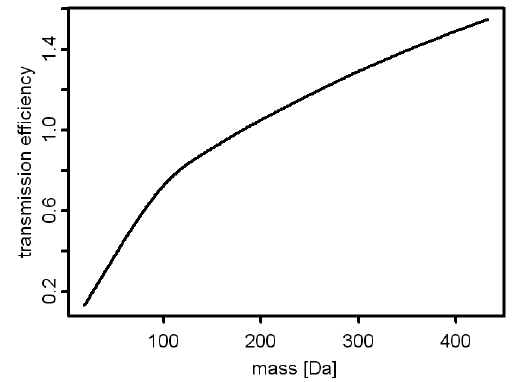
Figure D1. Fractional transmission efficiency of the PTR-TOF-MS system. Fig. D1. Fractional transmission efficiency of the PTR-TOF-MS